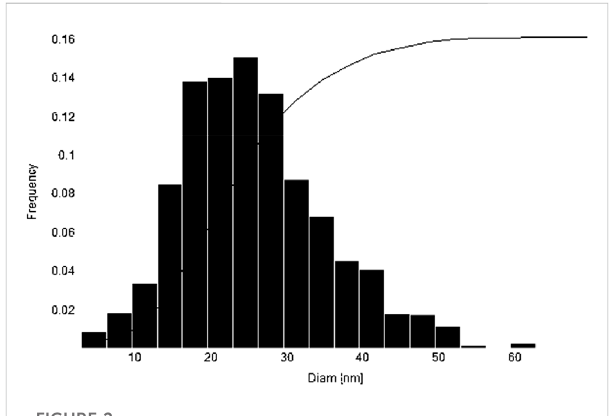
FIGURE 2 Histogram curve of magnesium oxide